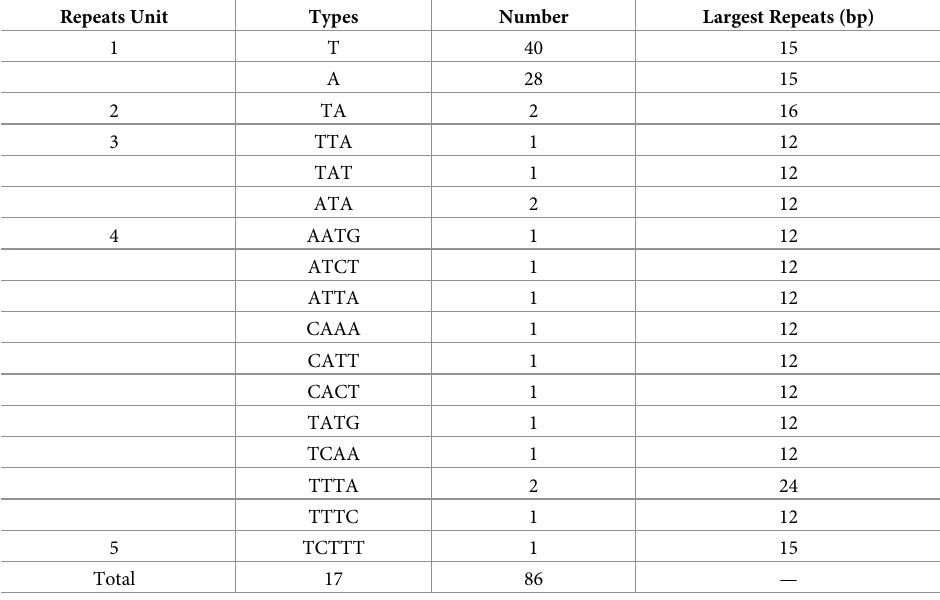
Table 3. Summary of simple sequence repeats in Houttuynia cordata cp genome.